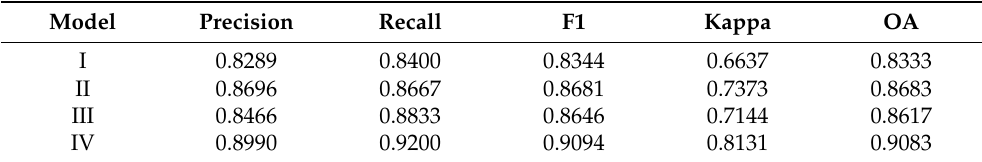
Table 4. Comparison of the accuracies of the models with different module combinations in test area B.